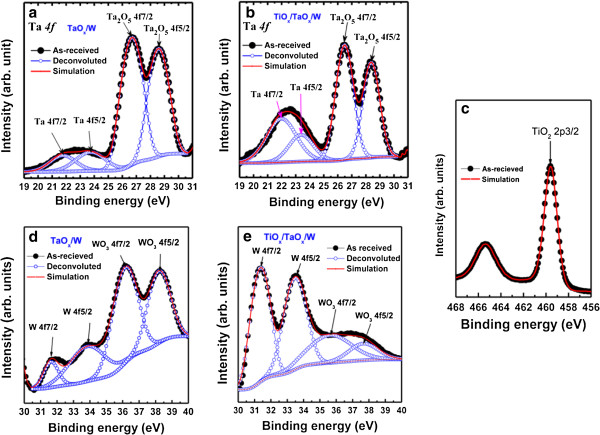
XPS characteristics. Ta 4f spectra for (a) TaOx/W and (b) TiOx/TaOx/W structures. (c) Ti 2p spectrum. W 4f and WO34f spectra for the (d) TaOx/W and (e) TiOx/TaOx/W structures [22,114].